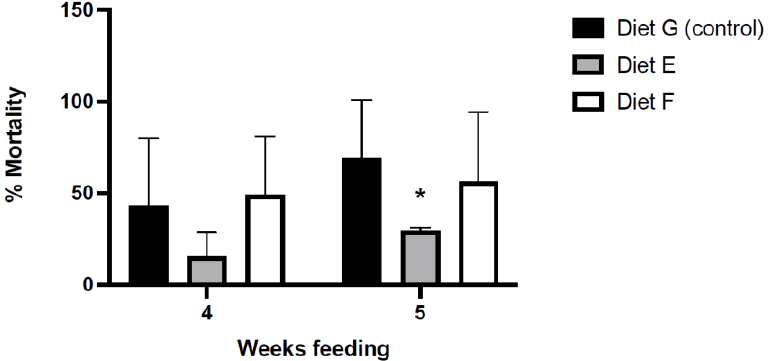
Figure 4. Average percentage of mortality in shrimps fed functional diets (for 4 or 5 weeks) and challenged with Vibrio parahaemolyticus ( Vp AHPND strain). *: significant differences in mortality (logistic regression analysis). The “casualty” and “survivor” data of the shrimp fed control diet G in challenge 1 (G1 tank) were used as reference for comparison, with the mortality of this group represented in the intercept of the